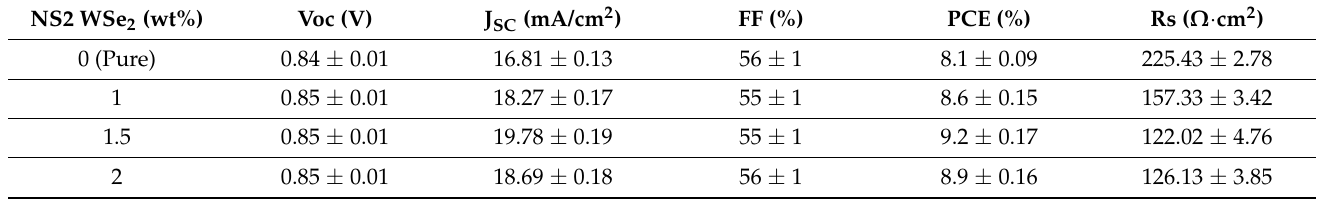
Table 2. PSC performances of pristine and different amounts NS2 WSe 2 NSs blended into the PBDB-T:PCBM active layer using constructed devices ( ± indicates the standard deviation).